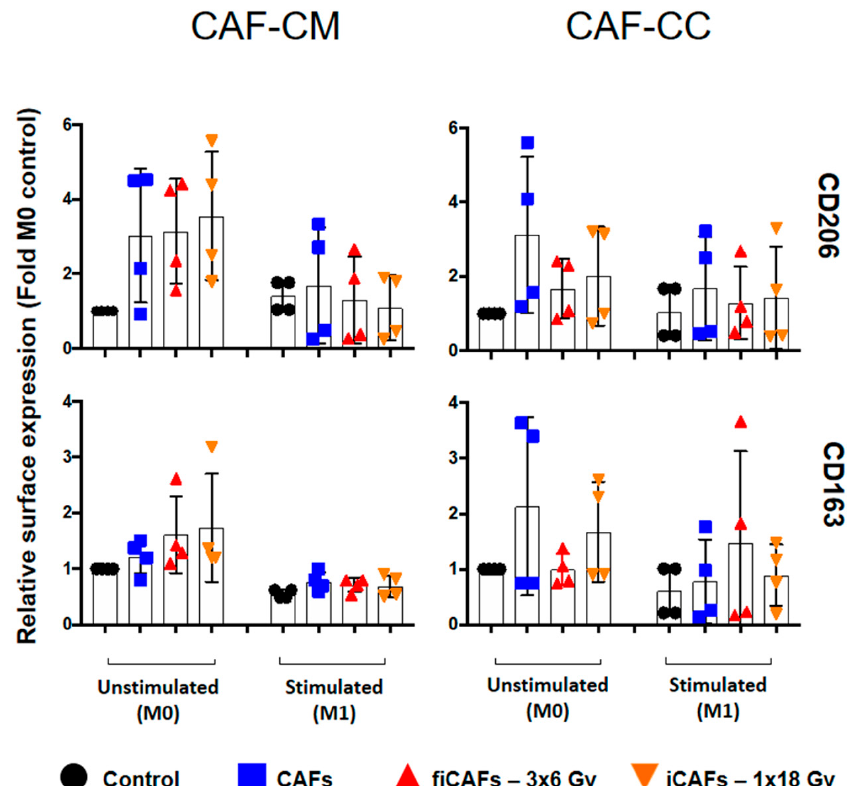
Figure 3. CAF-mediated effects on M2-macrophage cell surface markers. Monocyte-derived macrophages in non-stimulated or stimulated conditions were incubated with irradiated and non-irradiated CAF-conditionedmedium(CM)orinco-cultures(CC).ResultingexpressionofM2-macrophage cell surface markers CD206 and CD163 was evaluated by flow cytometry. Filled black circles indicate expression levels in control macrophage cultures (M0 and M1). Results are expressed as fold M0-controls. Data represent the mean ( ± SD) values from four-4 di ff erent CAF donors in conditioned medium experiments and three donors in co-culture experiments were measured independently. Non-parametric Kruskal-Wallis test and p -values were determined between control and non-irradiated CAFs, control and the two iCAF-groups individually. iCAF (irradiated CAFs); fiCAFs: fractionated-irradiated